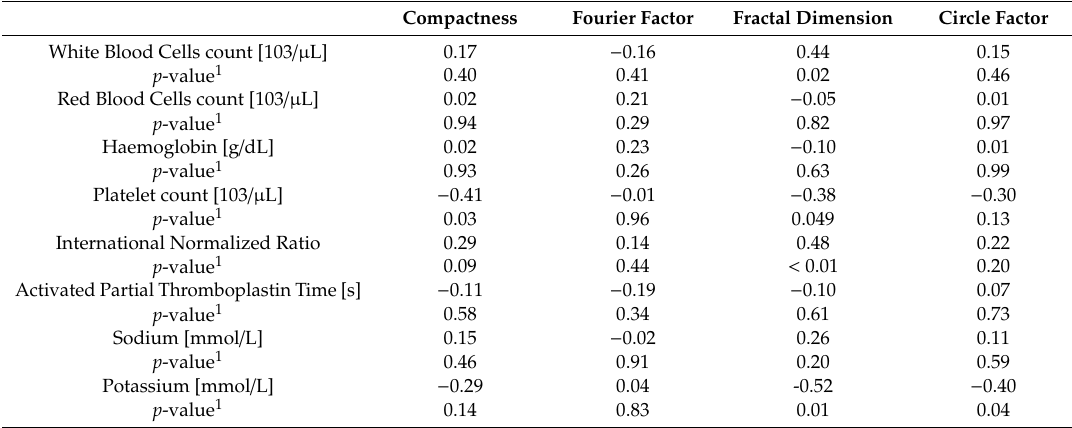
Table 3. Correlation of ICH shape with blood test results taken upon admission. Compactness Fourier Factor Fractal Dimension Circle Factor White Blood Cells count [103 / µ L] 0.17